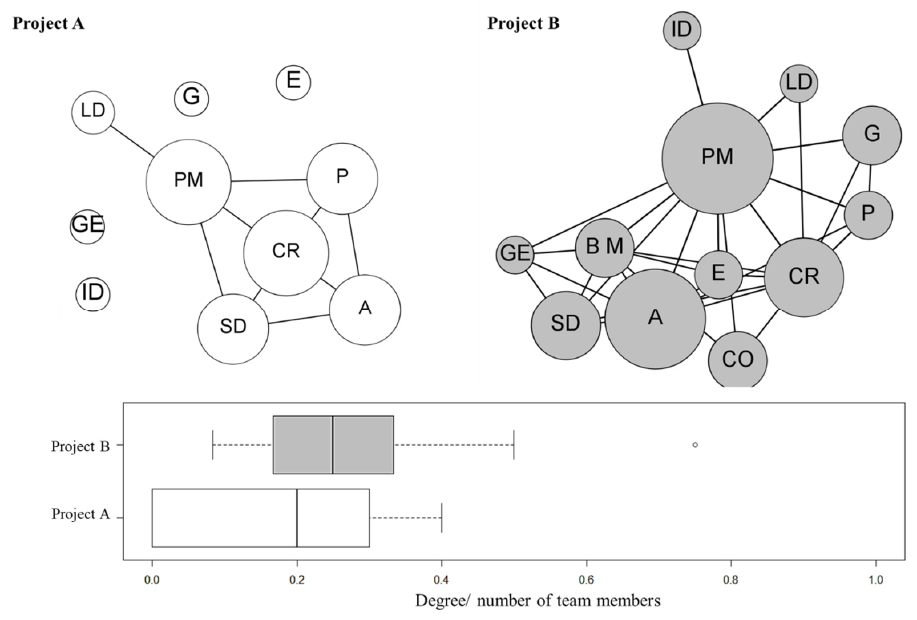
Figure 5. Collaboration network and degree: Project A and project B.